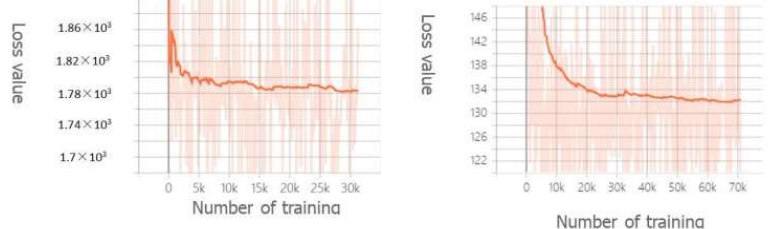
Figure 5. Loss value change.